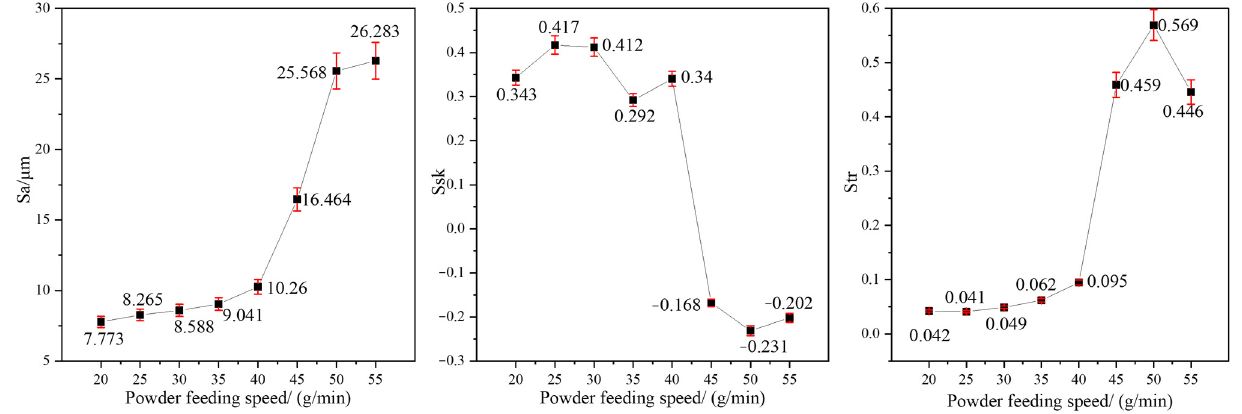
Figure 19. Variations of S a , S sk , and S tr with powder feeding speeds.